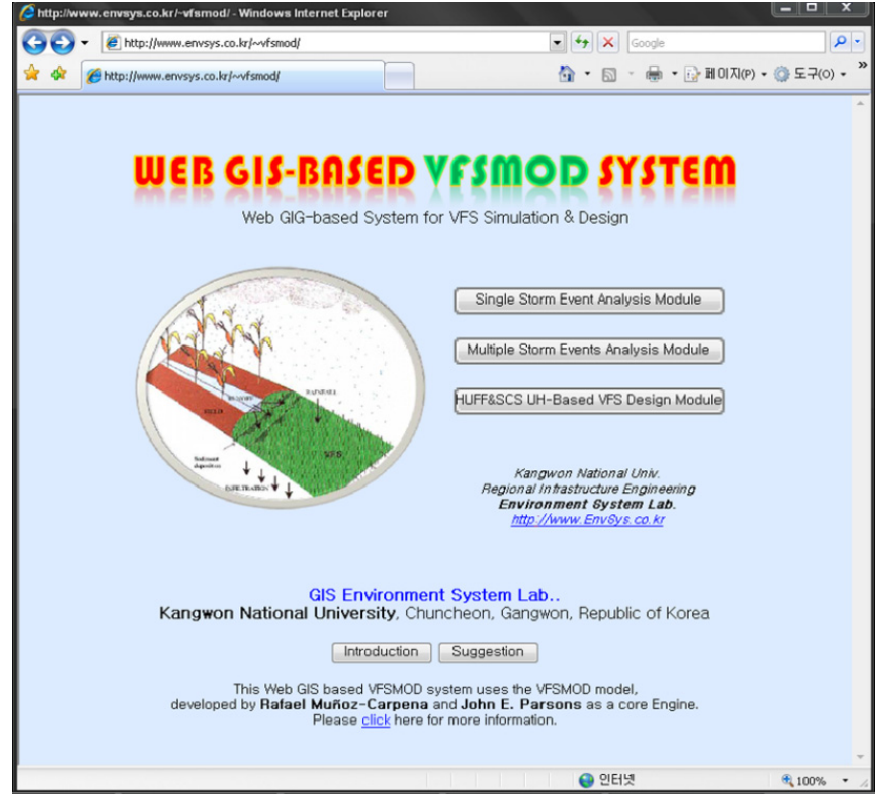
Figure 1. Single Storm Event Analysis module (SSEA), Multiple Storm Events Analysis (MSEA) module, and HUFF & SCS UH-based VFS design module in the Web GIS-based VFSMOD system [9].